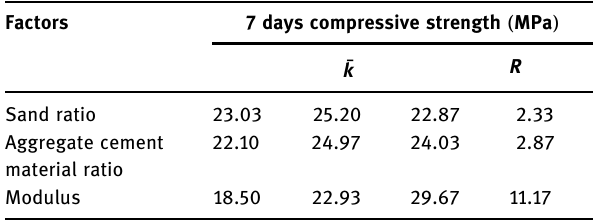
Figure 11: SEM observation apparatus.